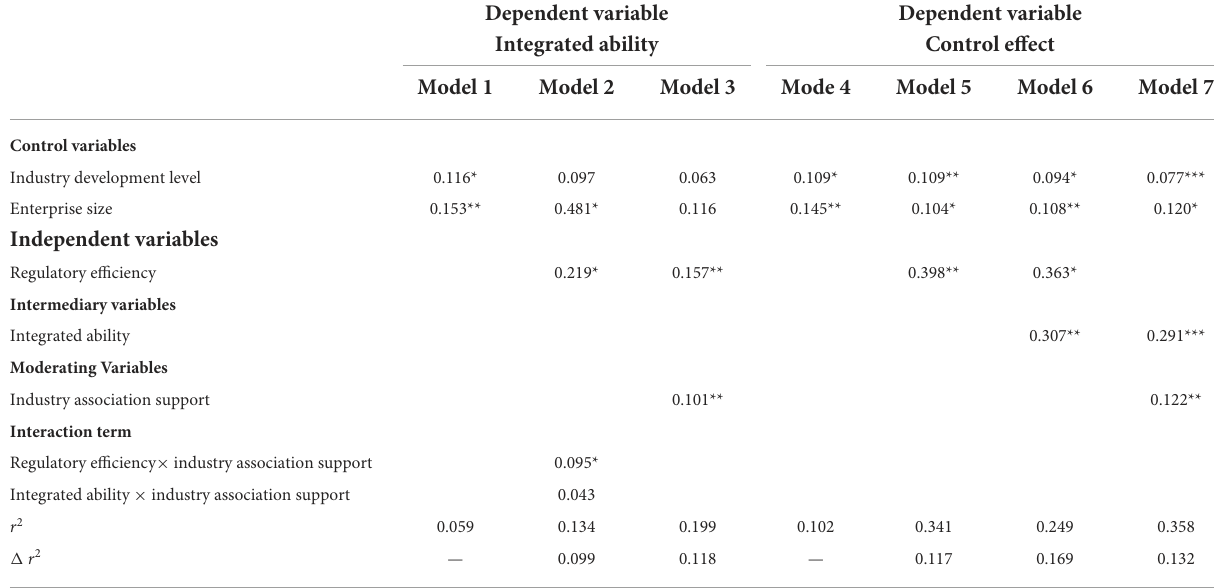
TABLE 9 Robustness test